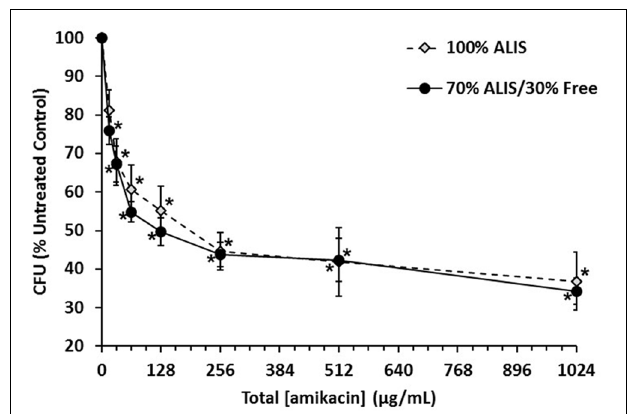
FIGURE 2 | Amikacin liposome inhalation suspension (ALIS) reduced viable cell counts in Mycobacterium avium biofilms. Biofilms (strain A5) were established for 7 days in plastic 96-well plates and then treated for 4 days with either 100% ALIS or a 70% ALIS/30% free amikacin mixture that replicates the ratio of liposomal to free amikacin after nebulization. Three independent experiments were performed on different days, with three technical replicates for each condition tested. The colony forming unit (CFU) count for each concentration was normalized as percent of the untreated CFU count within each experiment and then group means and standard errors were calculated. ∗ P < 0.05 compared to no amikacin by one-way ANOVA with Dunnett’s multiple comparisons